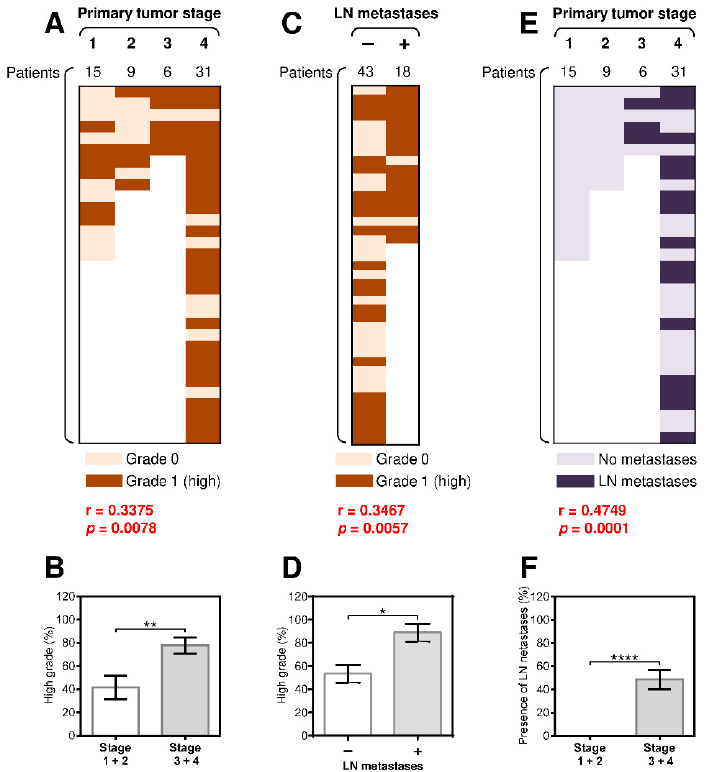
Figure 1. The presence of regional lymph node (LN) metastases significantly correlates with tumor grade and the primary tumor stage. ( A ) The cohort of 61 salivary gland cancer (SGC) patients was stratified into 4 groups according to the primary tumor stage, and the Spearman correlation with tumor grade (grade 0: light brown, grade 1: dark brown) was determined. ( B ) The patient cohort in ( A ) was stratified into 2 groups according to the primary tumor stage (group 1: stage 1 and 2 patients, group 2: stage 3 and 4 patients), and the proportion of high-grade tumors in each group was determined. ( C ) The patient cohort in ( A ) was stratified into 2 groups according to the presence ( + ) or absence ( – ) of LN metastases, and the correlation with the primary tumor stage was determined as in ( A ). ( D ) The proportion of high-grade tumors in each group in ( C ) was determined. ( E ) The patient cohort in ( A ) was stratified into 4 groups according to the primary tumor stage, and the correlation with LN metastases (no LN metastases: light blue, grade 1: dark blue) was determined. ( F ) The patient cohort in ( E ) was stratified into 2 groups according to the primary tumor stage (group 1: stage 1 and 2 patients, group 2: stage 3 and 4 patients), and the proportion of patients with LN metastases in each group was determined. In ( A ), ( C ), and ( E ), the correlations were evaluated by Spearman correlation tests ( n = 61). * p < 0.05 was considered significant. In ( B ), ( D ), and ( F ), the difference between the stratified groups of patients was evaluated by the Mann–Whitney U test (stages 1 and 2, n = 24; stages 3 and 4, n = 37; * p < 0.05, ** p < 0.01, *** p < 0.001, **** p < 0.0001). The data are shown as the mean ± standard error of mean